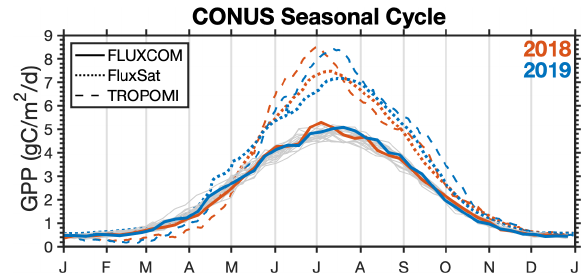
Figure 5. Comparison of the seasonal cycle inferred from TROPOMI SIF to FluxCom and FluxSat. Red lines indicate the 2018 seasonal cycle, and blue lines indicate the 2019 seasonal cycle for TROPOMI (dashed lines), FluxSat (dotted lines), and FluxCom (solid lines). Thin gray lines are years 2001–2017 for